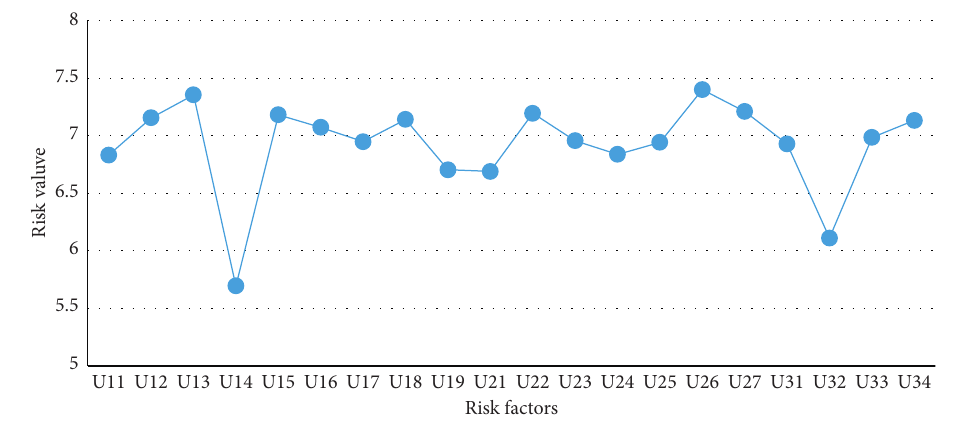
Figure 11: The risk values of risk indicators. Table 11: The total calculation